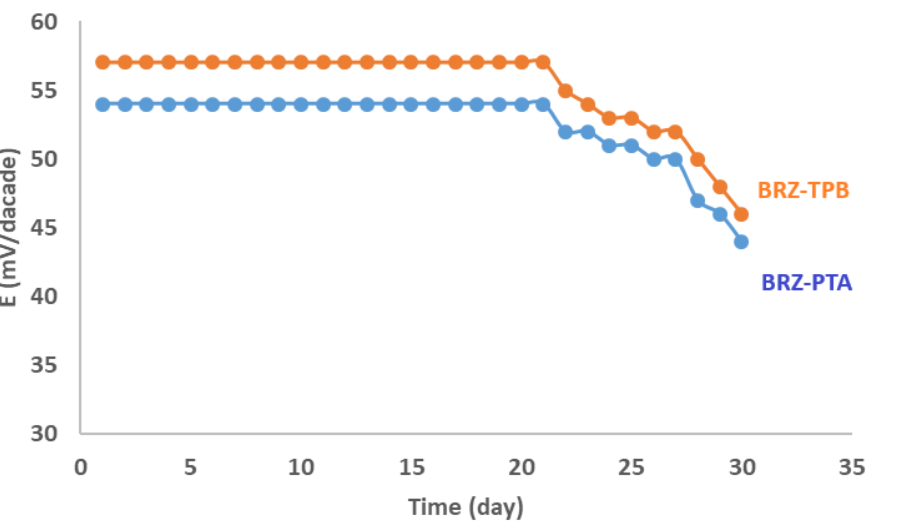
Figure 3. Effect of pH on the potential response bromazepam-phosphotungstate (BRZ-PTA) and bromazepam-tetraphenyl borate (BRZ-TPB membrane sensors.